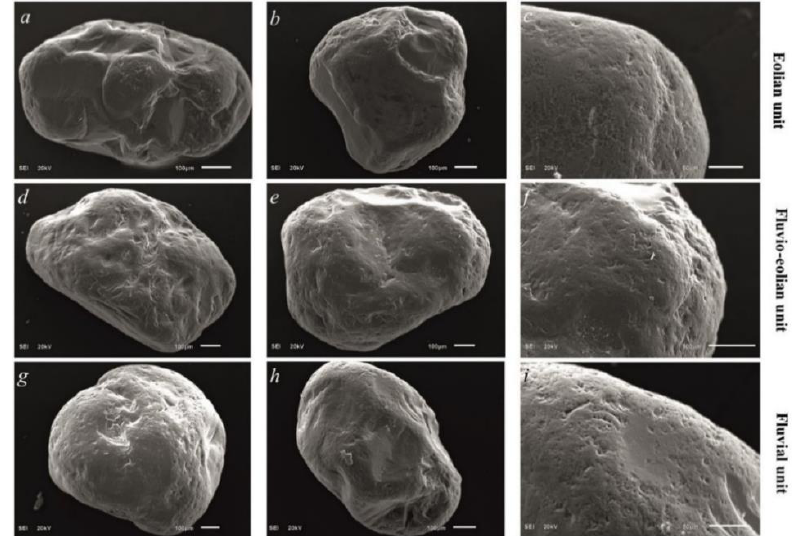
Figure 5. SEM photographs of representative quartz grains from di ff erent complexes of the TK2 section: ( a ) half-matte grain with small-pitted and micro-pitted surface structure and conchoidal fractures; ( b ) glossy grain with micro-pitted surface and visible traces of chemical weathering; ( c ) half-matte grain with fine-pitted and micro-pitted surface structure; ( d ) matte grain with micro-pitted surface; ( e ) glossy grain with V-shaped and crescentic marks; ( f ) surface with V-shaped and crescentic marks; ( g ) glossy grain with micro-pitted surface structure; ( h ) half-matte grain with micro-pitted surface structure and crescentic marks; ( i ) half-matte grain with fine-pitted surface structure and crescentic marks.